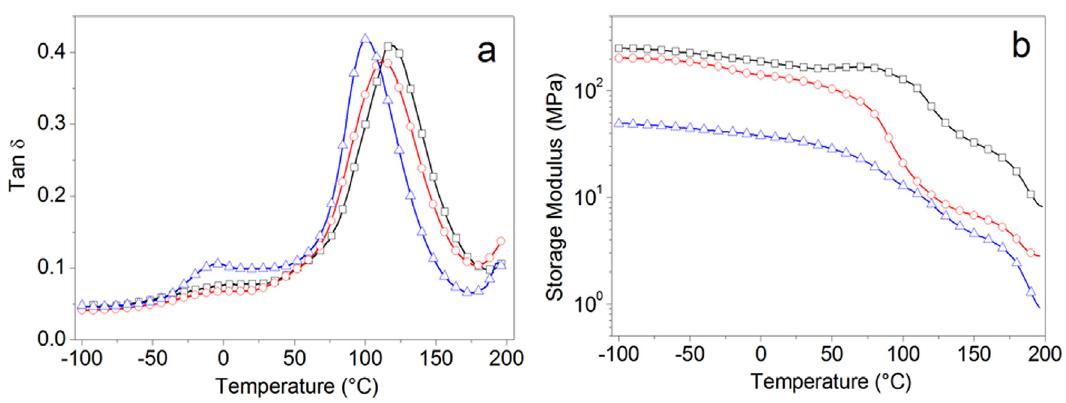
Figure 6. Tangent delta (a) and storage modulus values (b) as a function of temperature for PVA/CS mats at 70:30 (M3, squares), 75:25 (M4, circles) and 85:15 (M6, triangles) compositions.